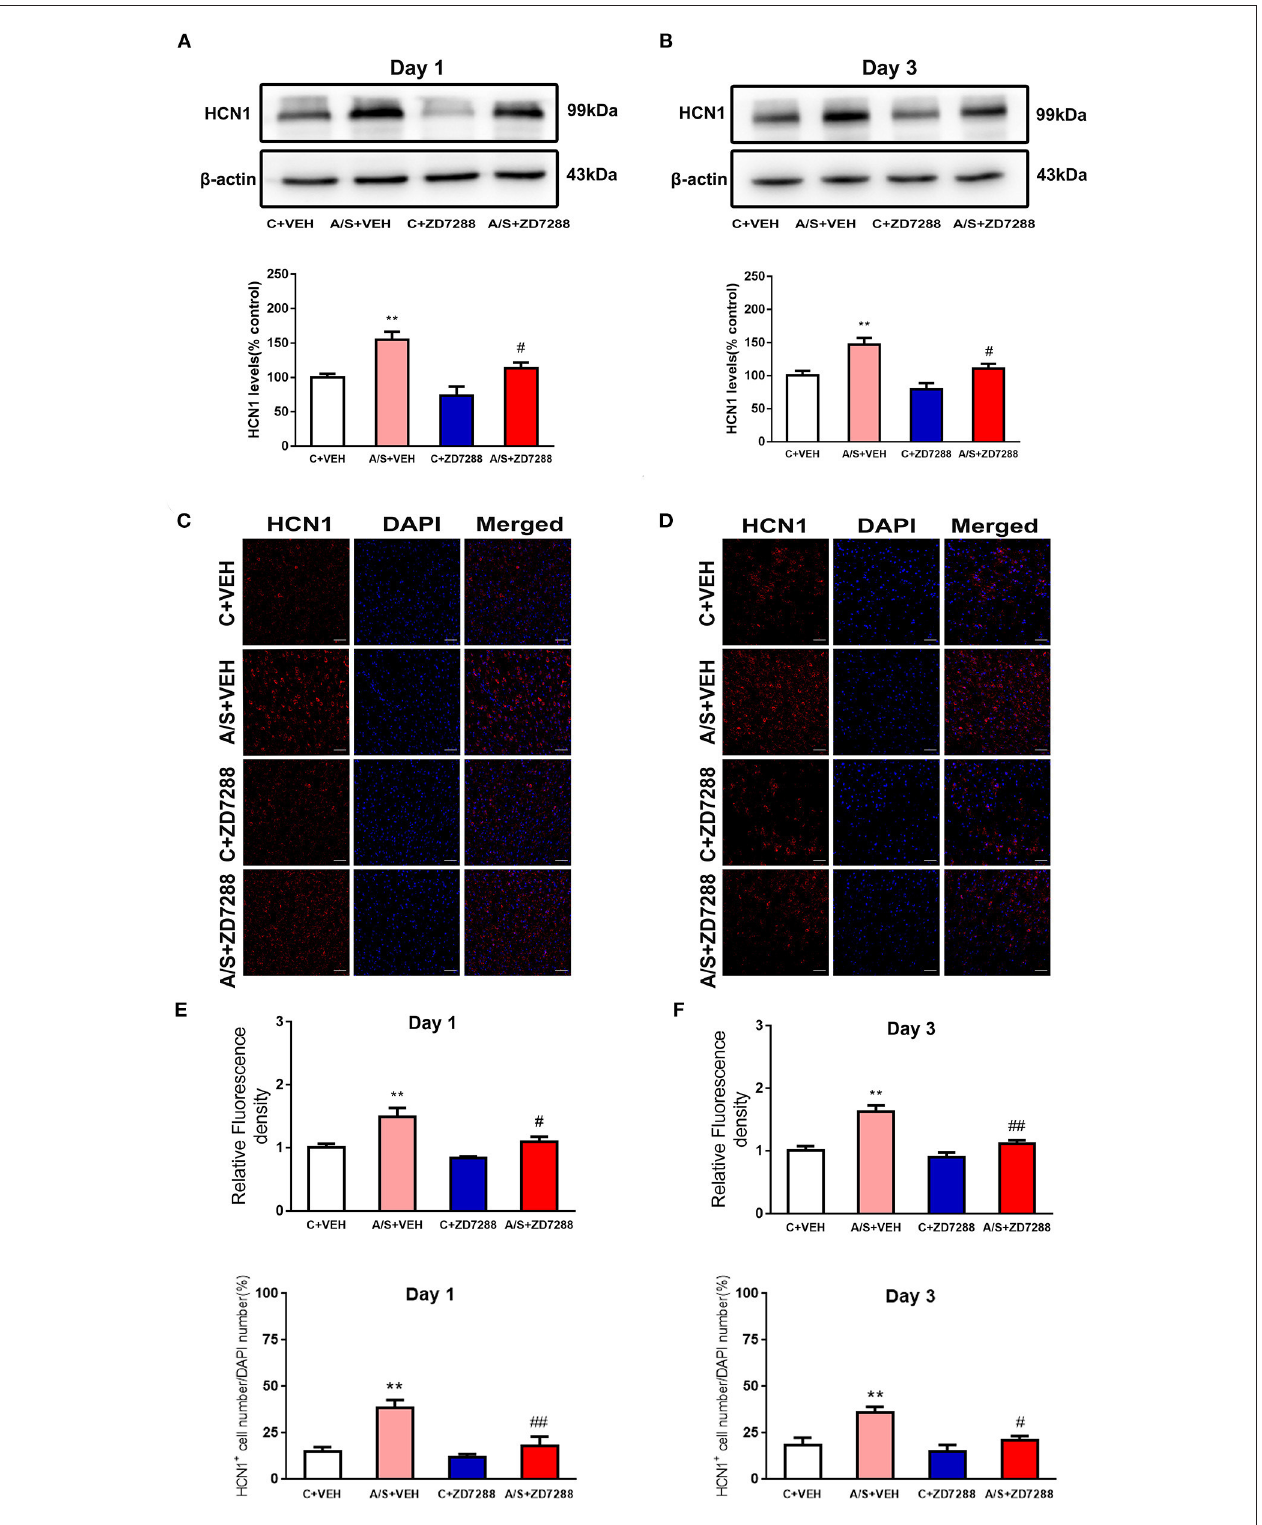
FIGURE 5 | Effect of ZD7288 on the HCN1 channel. (A,B) Representative western blots and quantification of HCN1 levels in mPFC area. (C–F) Representative images and quantification of HCN1 fluorescence in mPFC area ( n = 6 per group, * p < 0.05; ** p < 0.01; # p < 0.05; ## p < 0.01). Data are presented as the means ± SEM.